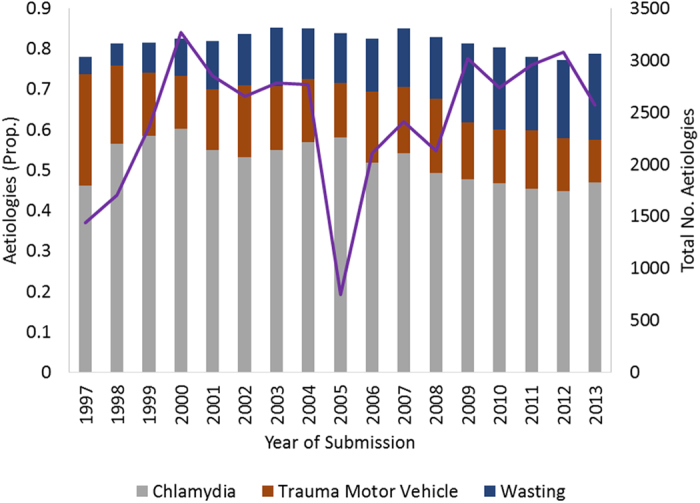
Total counts and proportions of aetiologies Chlamydia-like signs, trauma caused by motor vehicles, and wasting occurring in koalas submitted to wildlife hospitals in SEQLD from 1997–2013 (No. of occurrences of aetiologies = 41,606).